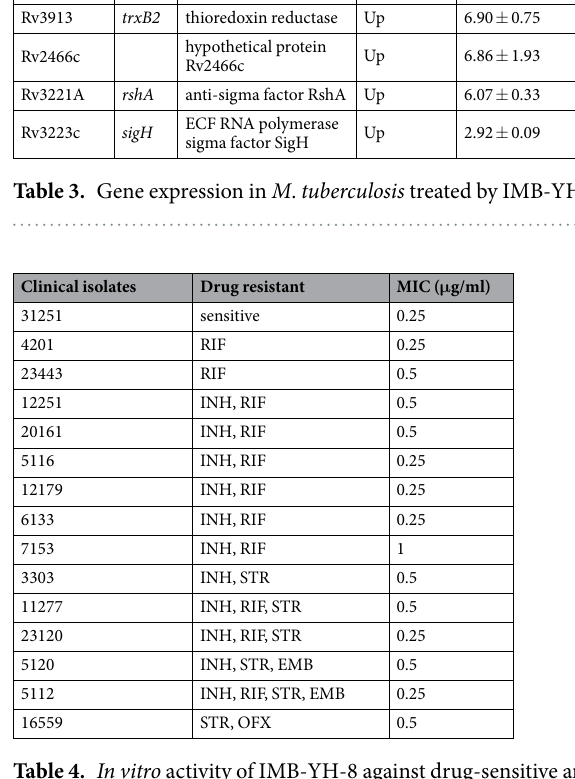
Table 4. In vitro activity of IMB-YH-8 against drug-sensitive and drug-resistant clinical isolates of M . tuberculosis . INH, isoniazid; RIF, rifampin; STR, streptomycin; EMB, ethambutol; ofloxacin,